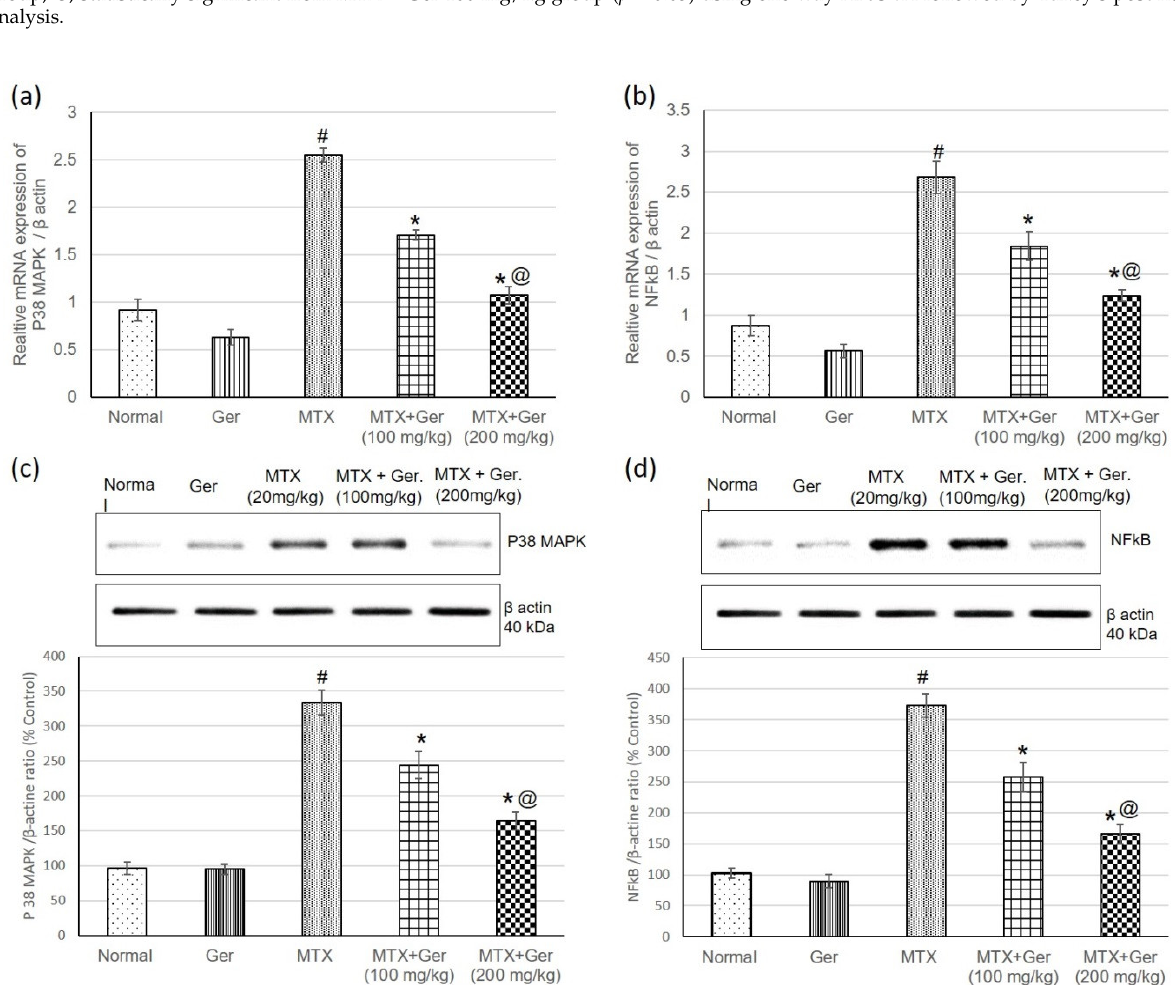
Figure 4. Effects of treatment with Ger (100 and 200 mg/kg) for 19 days on the P38 MAPK/NF- κ B signaling pathway: mRNA expression on ( a ) P38 MAPK and ( b ) NF- κ B levels and on protein expression of ( c ) P38 MAPK and ( d ) NF- κ B levels in MTX-induced AKI in rats ( n = 6). All values are expressed as mean ± SD. #, statistically significant from normal group; *, statistically significant from MTX-only group; @, statistically significant from MTX + Ger 100 mg/kg group ( p < 0.05) using one-way ANOVA followed by Tukey’s post hoc analysis.